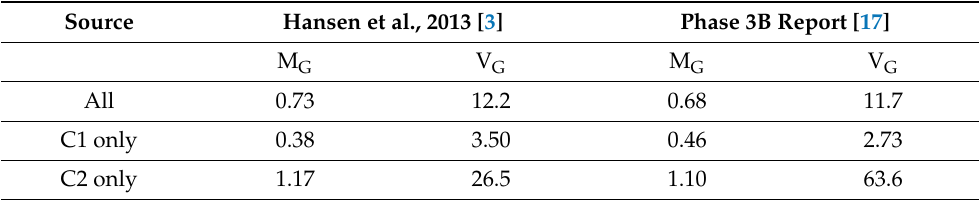
Table 1. Geometric Mean and Variance: direct dispersion–explosion simulations.